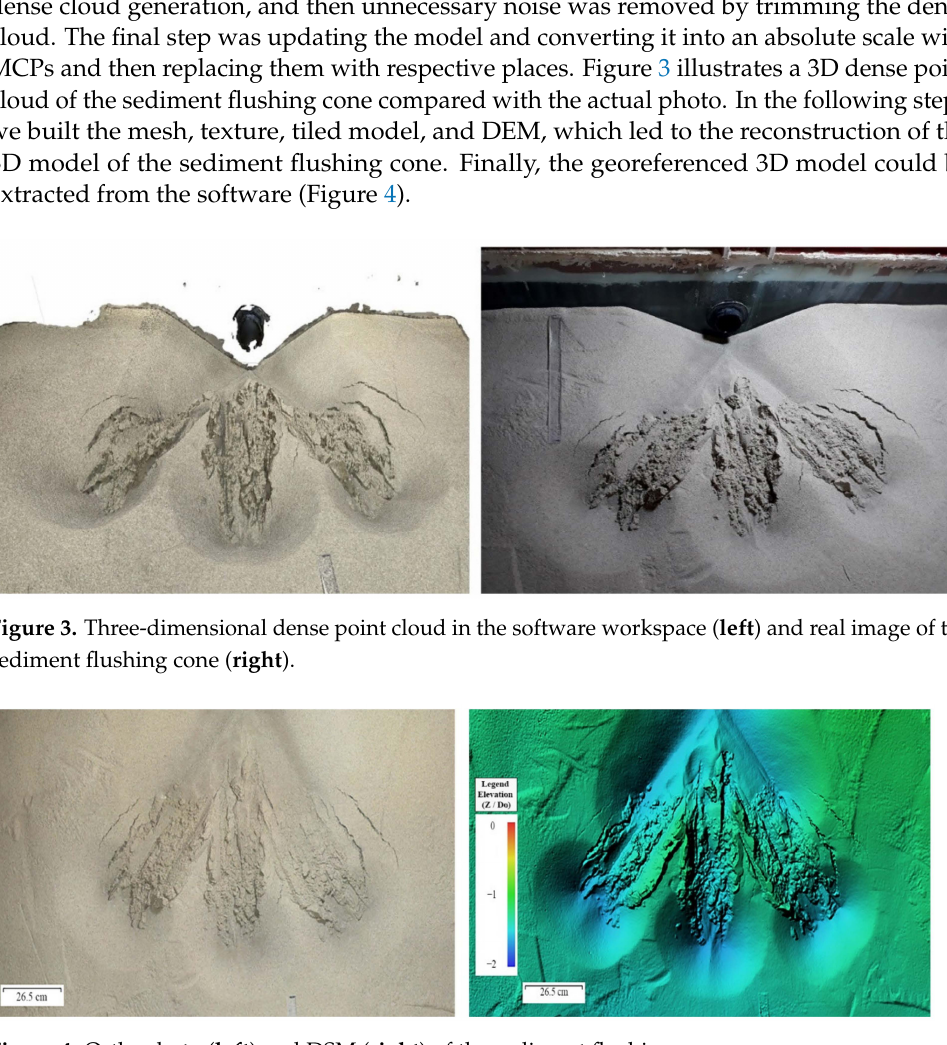
Figure 4. Orthophoto ( left ) and DSM ( right ) of the sediment flushing